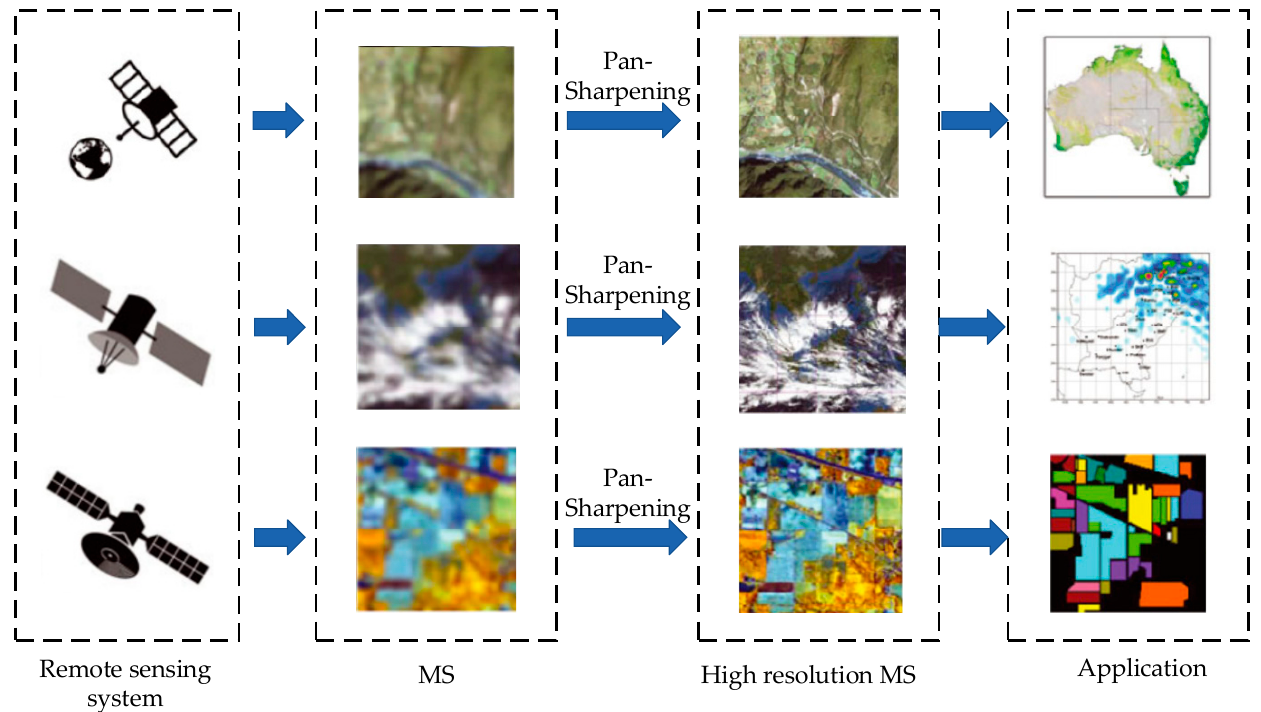
Figure 1. Application of the pan-sharpening method.